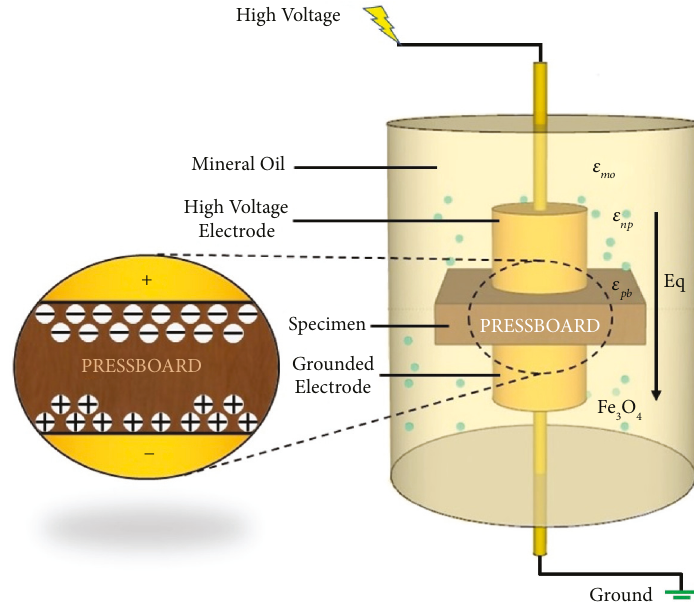
Figure 11: Schematic diagram of electric field distribution and space charge grouping of impregnated pressboard with mineral oil-based Fe 3 O 4